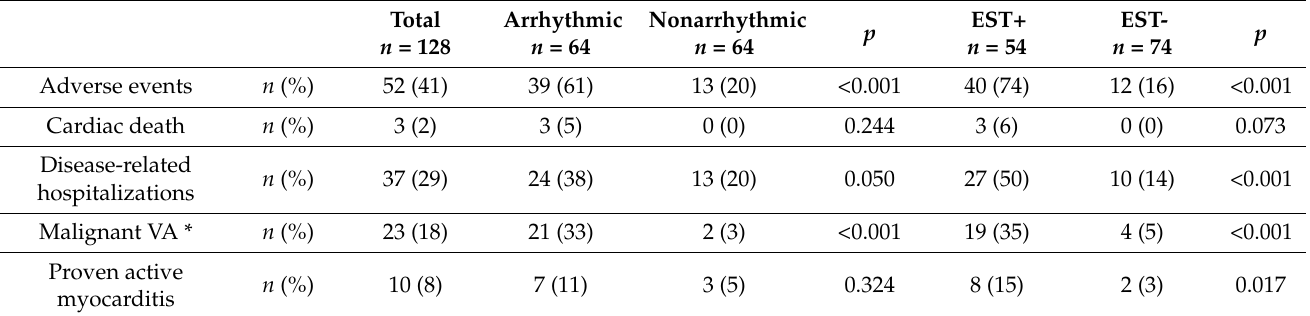
Table 4. Outcomes after exercise stress test.